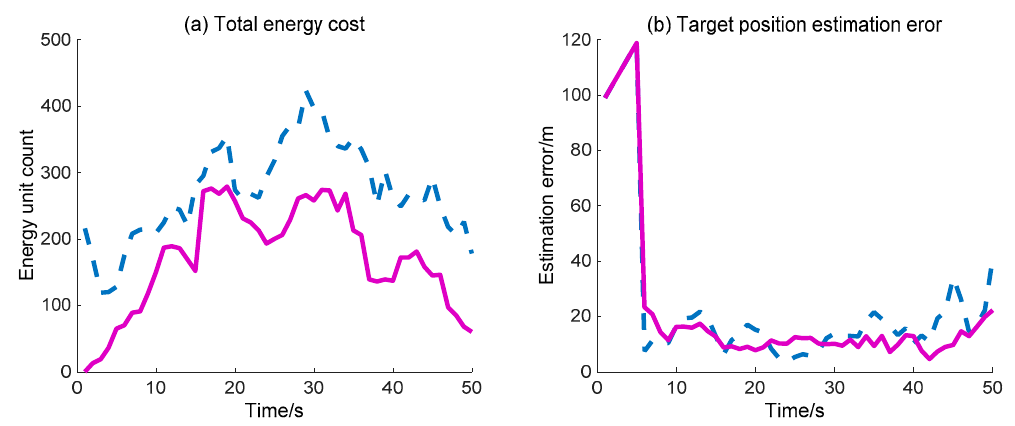
19 of 22 Figure 13. The WC performance of the sending and receiving messages numbers: ( a ) Number of sending messages. ( b ) Number of receiving messages. ( — : BDIIM; -- : DIDM). The target position estimation error and total energy cost of WSN are also simulated and compared with the previously mentioned DIDM method. Here, the target position estimation error denotes the distance between the actual target position and the estimate position (the centroid of the valid waked sensor nodes). As for the total energy cost, we consider that the energy consumed by the “idle” sensor node in each time interval is one unit, and one sensor node sending/receiving a message is also considered one unit. Due to the fact that the calculation operation costs much less energy compared with the operation of sending/receiving messages, the calculation cost is not considered. In Figure 14, the total energy cost across the whole process via the proposed BDIIM method is always less than